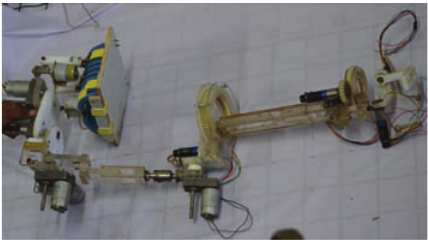
Figure 2: Manufacturing model of